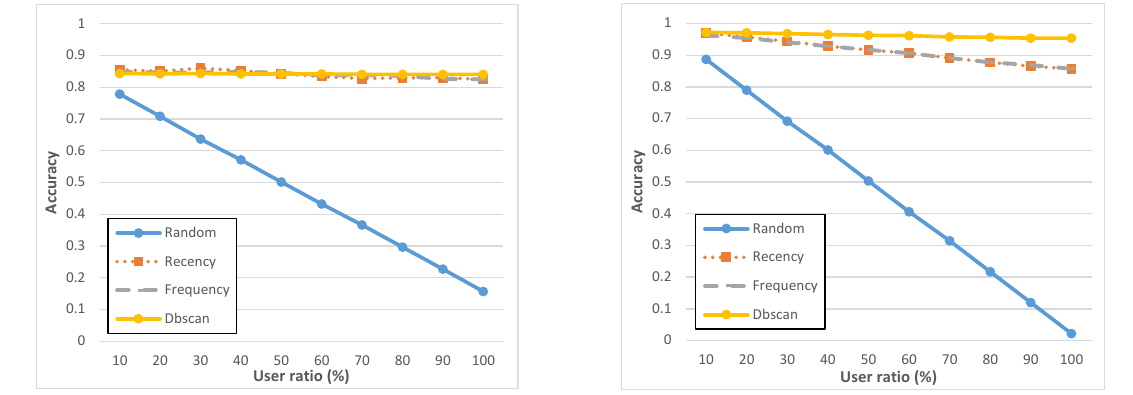
Figure 7. Accuracy on geo-notified ( left ) and non-geo-notified ( right ) tasks.